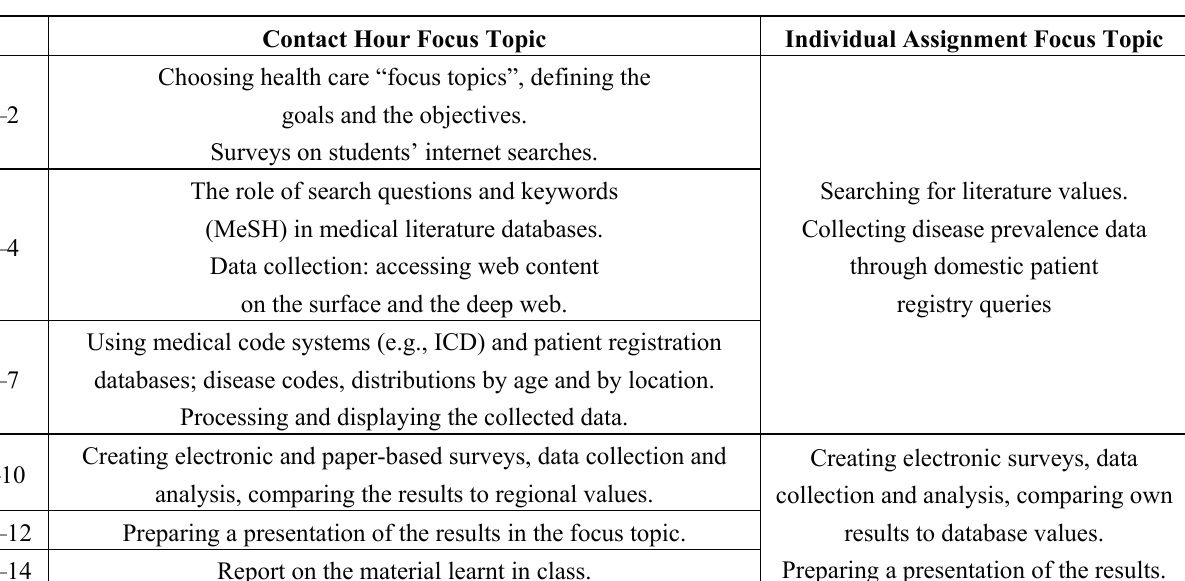
Table 2. The schedule of the 5th